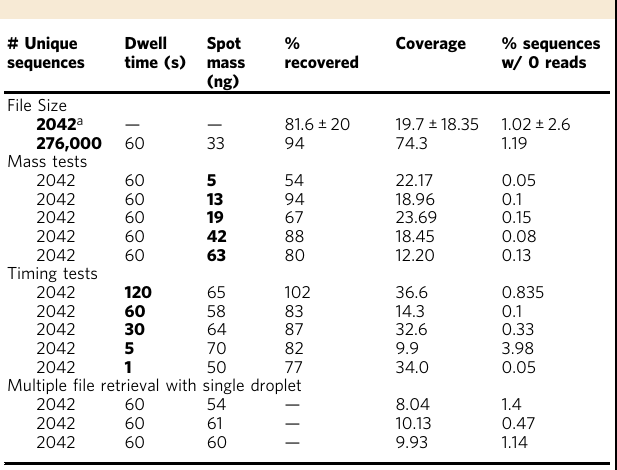
Table 3 Retrieval results for larger spot masses (greater than 180 ng, see Section 2) to demonstrate feasibility